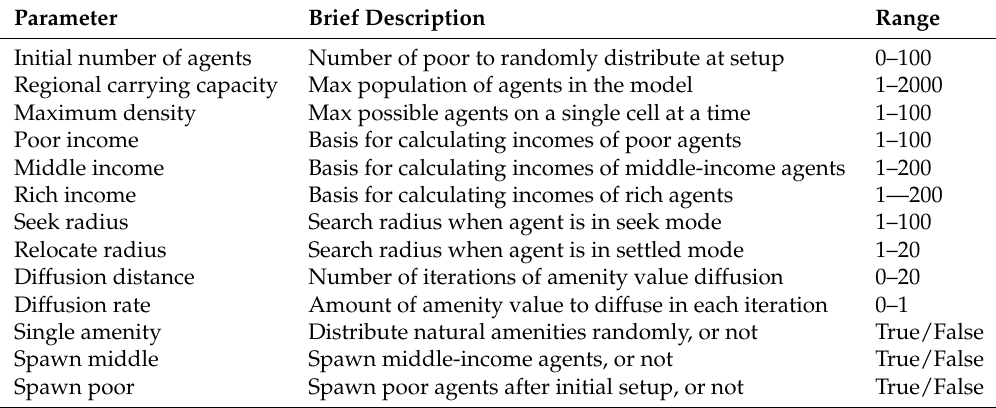
Table 1. Model parameters and summaries. See accompanying text for a complete description of